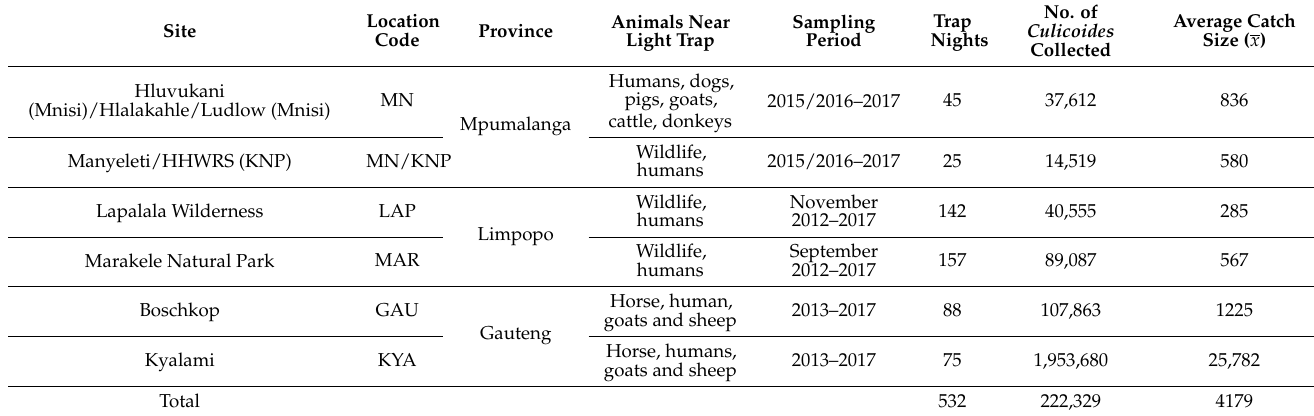
Table 1. Culicoides collection site information located in three provinces in South Africa, number (no.) of Culicoides collected per site and average catch size ( x ) from 2012 to 2017. Adapted from